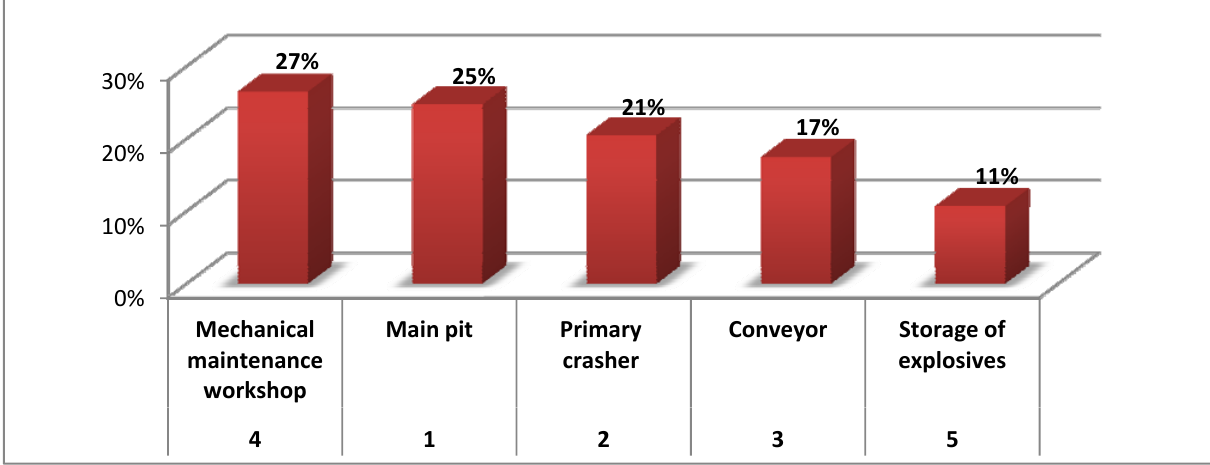
Figure 7. Criticality of the areas of the mine as perceived by the consulted workers.